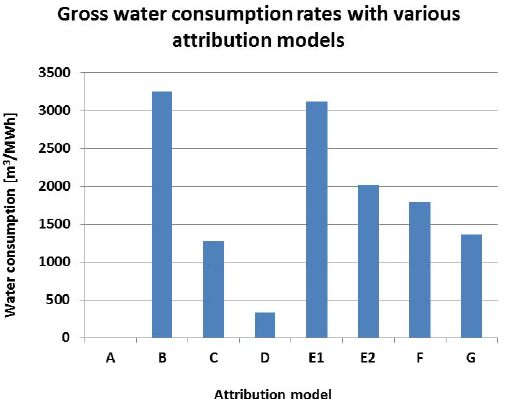
Fig. 6. The water consumption for hydropower in a multi-purpose reservoir, given different models to attribute losses. The figure is based on the numbers given in Table 6, where also the description of the models can be